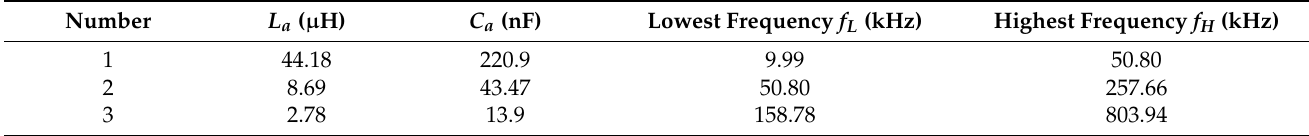
Figure 5. Relationship between frequency and auxiliary inductance. In order to realize the soft switching in the frequency range of 10 kHz–500 kHz, the selected auxiliary inductance and capacitance parameters are shown in Table 1. For example, when the LC parameter of number 1 is selected, soft switching can be realized in the range of 10–50 kHz, which is the advantage of the auxiliary circuit. By changing the number of the auxiliary circuit, the frequency range of the soft switching can be broadened. Table 1. Auxiliary current source parameters and corresponding frequency